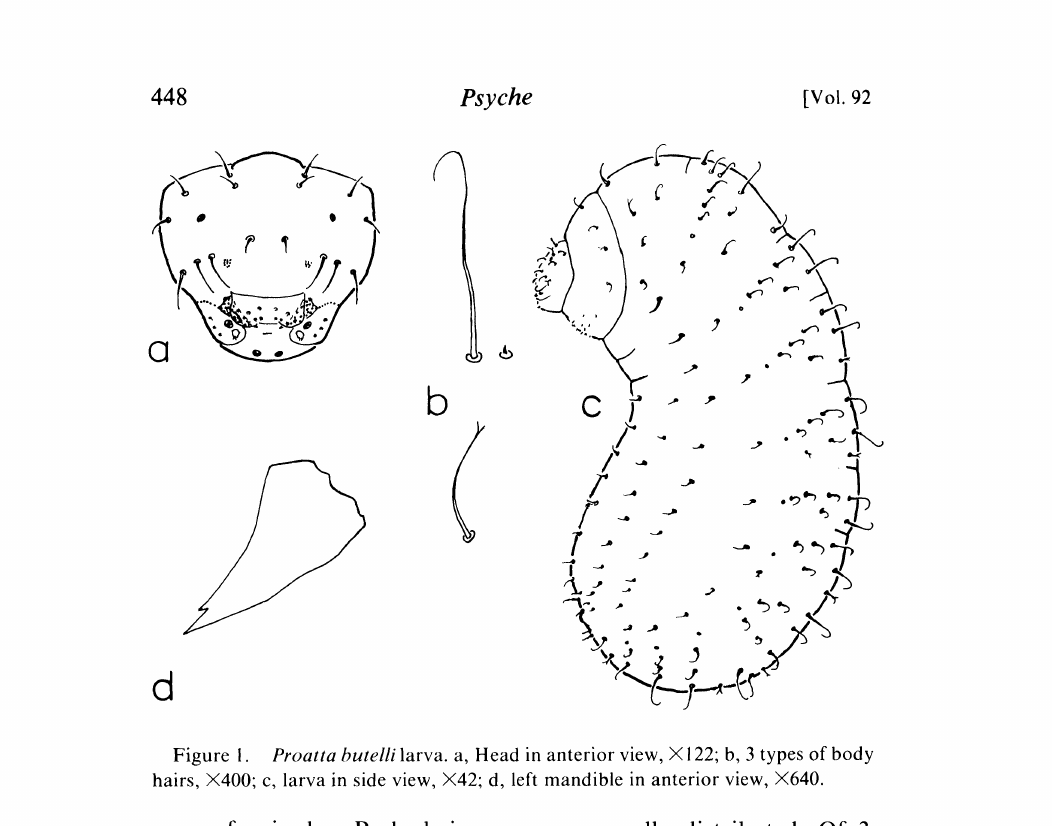
Figure 1. Proatta butelli larva, a, Head in anterior view, X 122; b, 3 types of body hairs, )<400; c, larva in side view, X42; d, left mandible in anterior view,